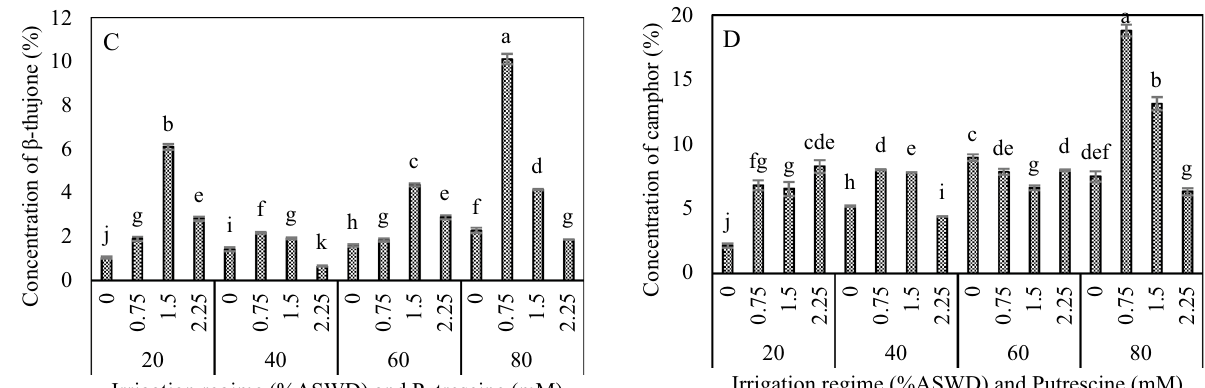
Figure 3. Interaction between irrigation regime and putrescine on concentration of 1,8-cineole ( A ), α-thujone ( B ), β-thujone ( C ) and camphor ( D ). The different letters show significantly different at the level of 0.01. The error bars represent standard error. (Retention Index = 1031, 1103, 1115 and 1144,